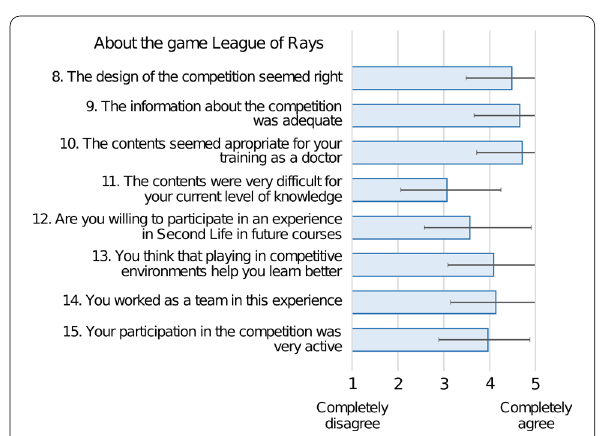
Fig. 6 Bar diagram expressing the mean of the results of the evaluation questionnaire about the League of Rays game on a five‑point Likert scale. Error bars represent the standard